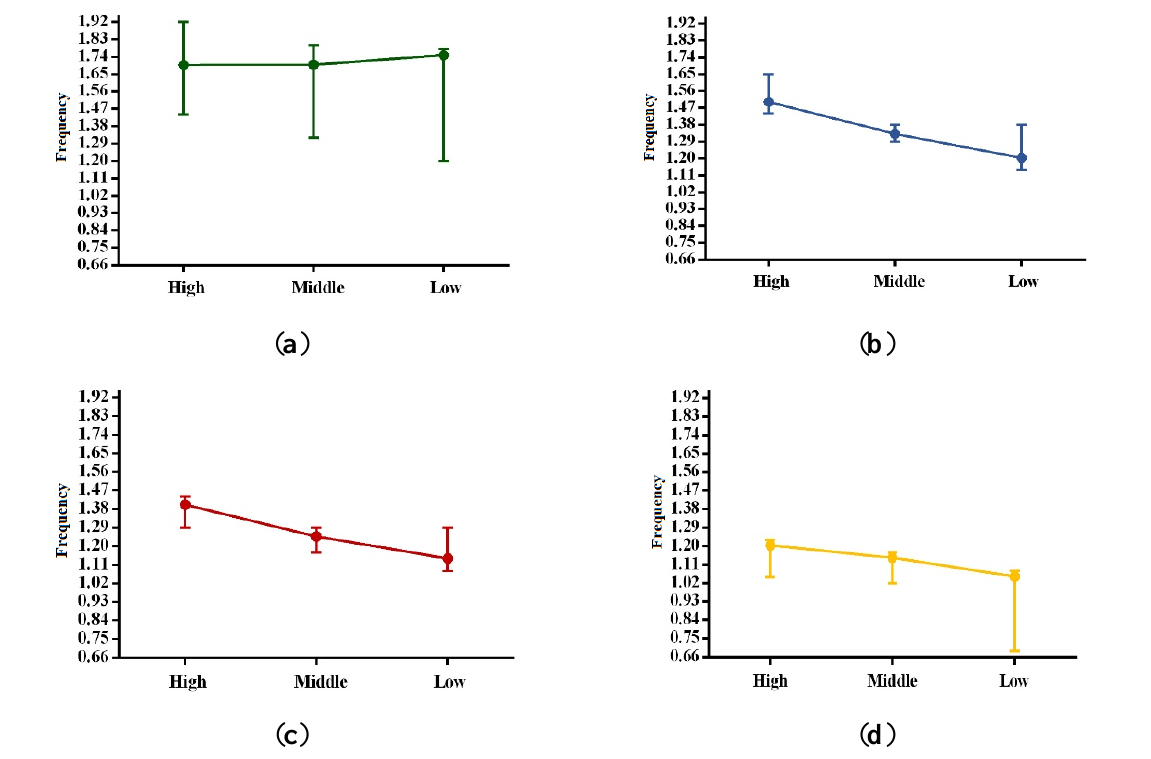
Figure 8. Changes in the distribution range of the different features’ 3D fractal